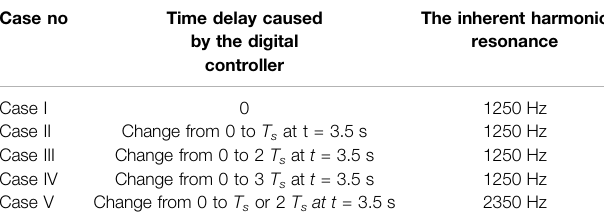
TABLE 1 | Five simulated cases corresponding to four kinds of time